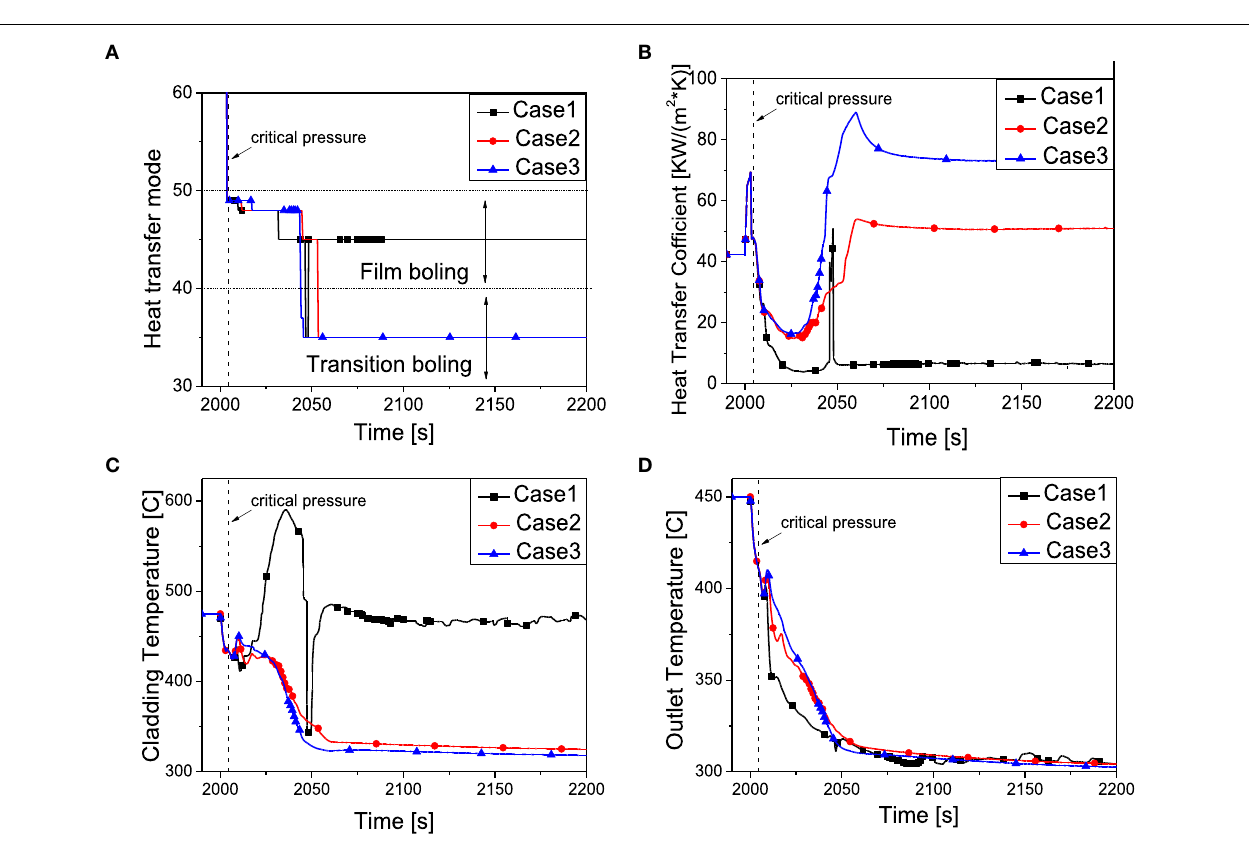
FIGURE 12 | System behavior by the effect of HTC to film boiling . (A) Heat transfer mode. (B) Heat transfer coefficient. (C) Peaking cladding temperature. (D) Core outlet